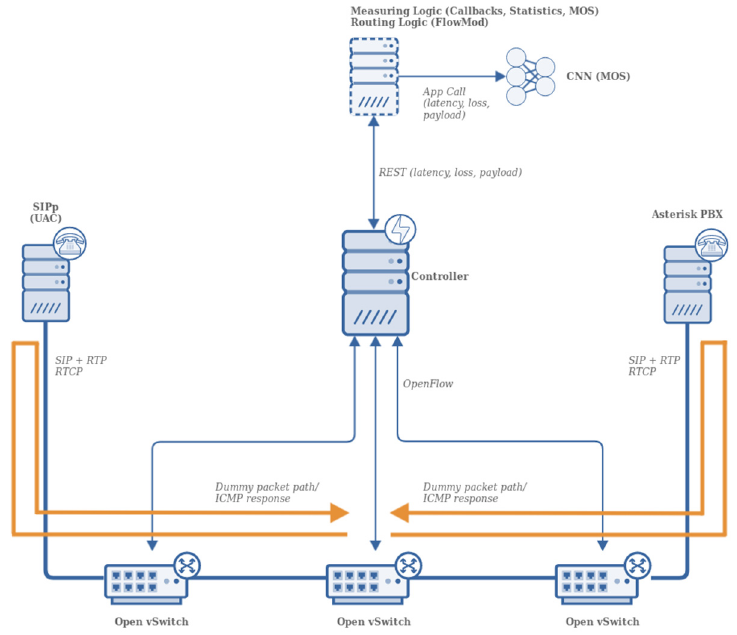
Figure 1. Logical test topology. SIPp generates calls that are routed through OpenFlow switches. Each time a new flow arrives at a switch, the controller is informed using OpenFlow.